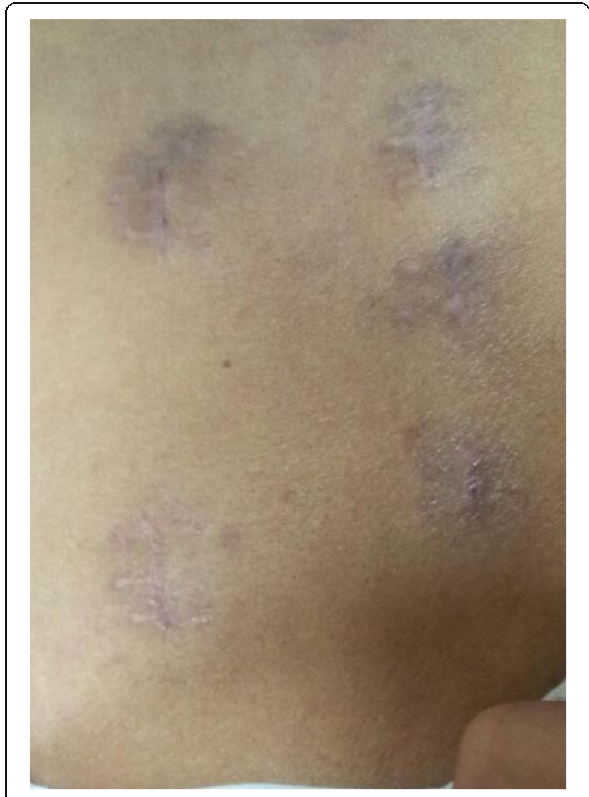
Fig. 16 Postoperative photo of wound after 3 months in a case of dorsal 12 fracture fixed by 5 screws D11 × D12 × L1. The patient VAS score was 8 and the physician score was 7, so the mean VAS score was